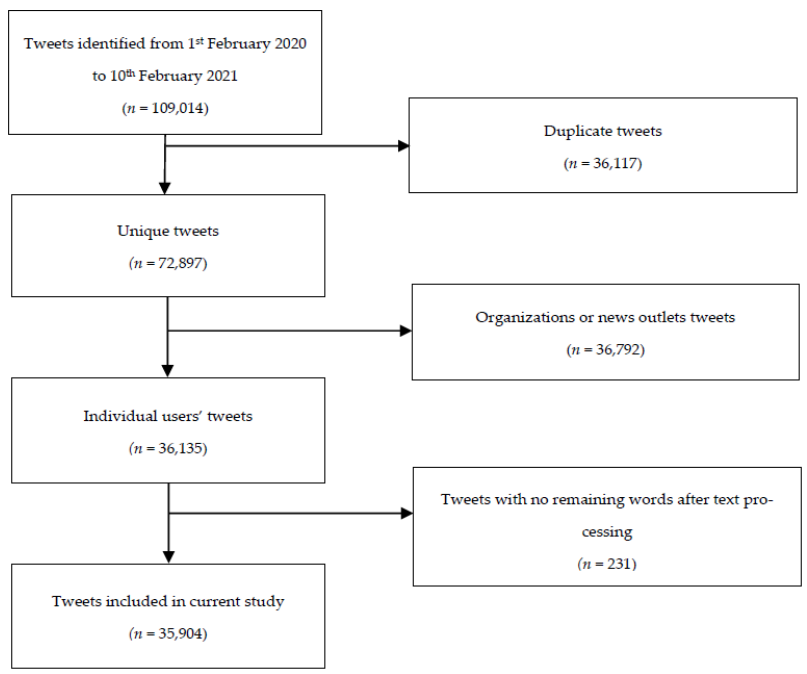
Figure 1. Flowchart illustrating the tweet selection process.